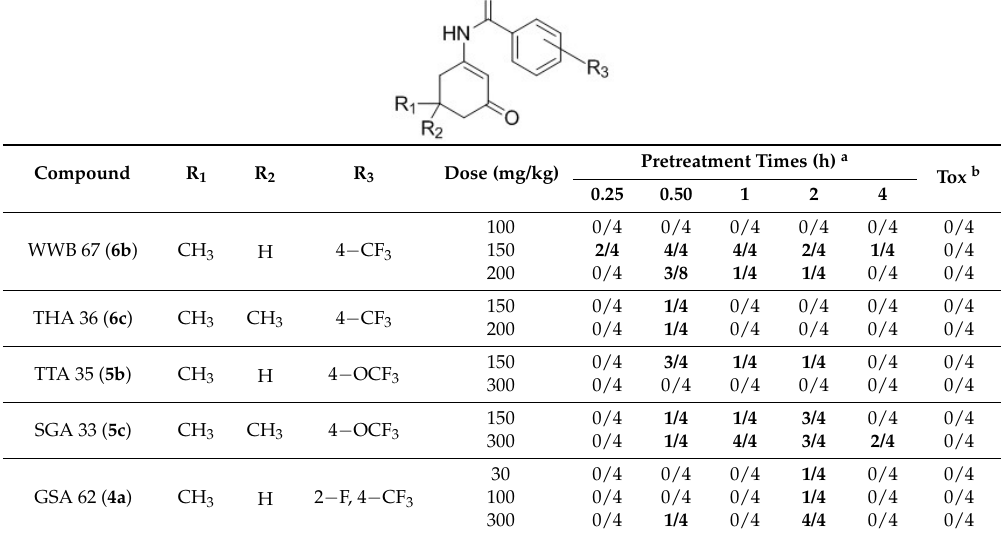
Table 3. Anticonvulsant activity: 6-Hz 44-MA test in mice.